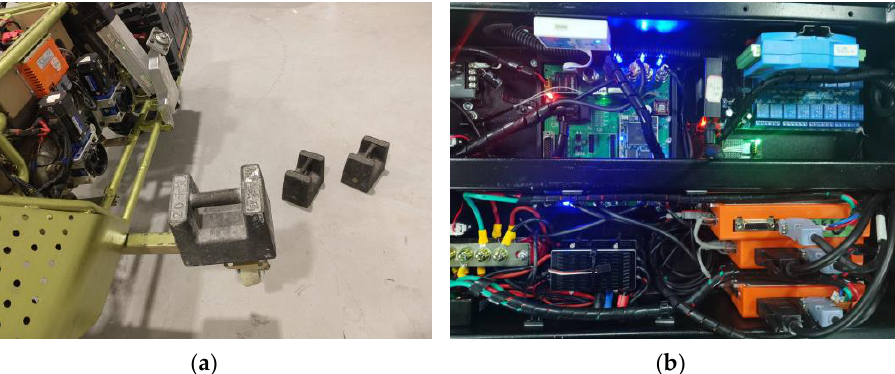
Figure 20. Prototype testing and hardware environment: ( a ) Prototype load test; and ( b ) Embedded system used in the prototype. Table 7. Information of the STM32H743.